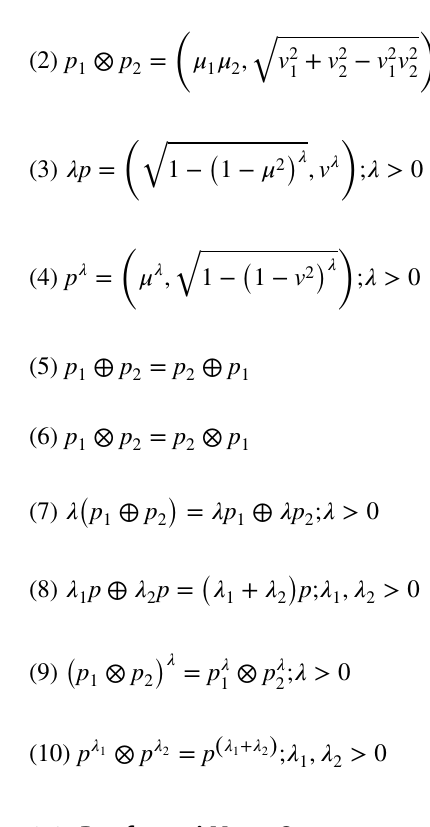
Fig. 1 Comparison of spaces of the PFNs and